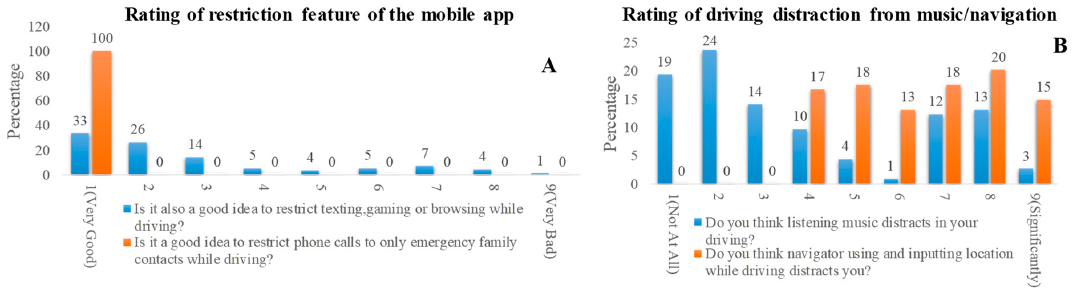
Figure 13. ( A ) Statistics for the questions on rating of restriction feature of the mobile app and ( B ) using mobile phone.